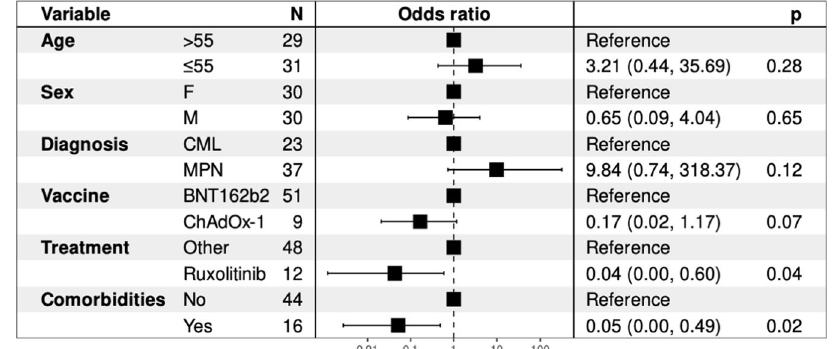
Fig. 2 Anti-S IgG Multivariate Analysis. Multivariate analysis of impact of age, sex, diagnosis, vaccine type, ruxolitinib treatment and presence of comorbidities on anti-S IgG response to